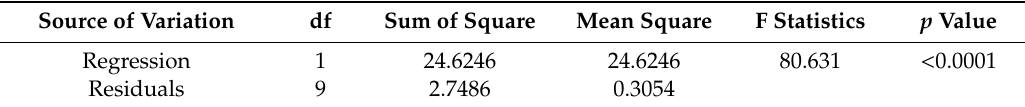
Table 2. Analysis of variance table computed for each simple linear regression model fitted to data of total chlorophyll and infrared vegetation index: normalized di ff erence vegetation index (NDVI).